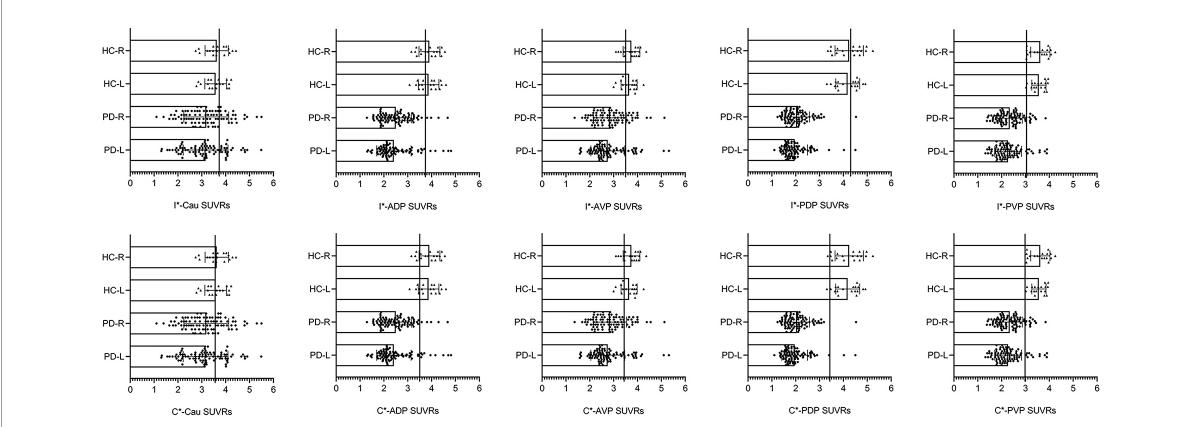
FIGURE2 Scatterplots with bars of the diagnostic SUVR of each subdivisions. HC-R, the right side of healthy controls in the validation cohort; HC-L, the left side of healthy controls in the validation cohort; PD-R, the right side of PD patients in the validation cohort; PD-L, the left side of PD patients in the validation cohort; I*-(ipsilateral), brain regions located at the side of clinical symptoms onset (PD group) in the derivation cohort; C*-(contralateral), brain regions located opposite to the side of clinical symptoms onset (PD group) in the derivation cohort; Cau, caudate; ADP, anterior dorsal putamen; AVP, anterior ventral putamen; PDP, posterior dorsal putamen; PVP, posterior ventral putamen. We presented the right and left side of healthy controls and PD patients in the validation cohort, but did not distinguish between the ipsilateral and contralateral sides of the PD patients. Then, the optimal diagnostic SUVRs of each subregion were put into the corresponding subregion of the validation cohort, and those with less than the corresponding diagnostic SUVR were defined as “PD patients.” Scatterplots with bars of each subdivision showed that the diagnostic SUVR of contralateral posterior dorsal putamen had the best diagnostic accuracy of 98.1%. The vertical line represents the cut-off value defined in the PET/MRI cohort.